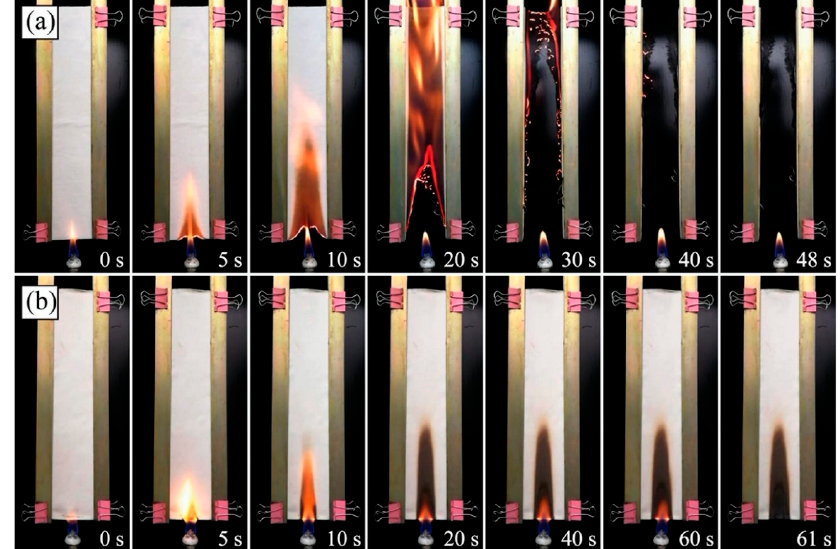
Figure 20. Digital images of uncoated and coated polyester fabrics after Limiting Oxygen Index testing. ( a ) uncoated polyester, ( b ) LbL-treated polyester—1 bi-layer, ( c ) LbL-treated polyester—5 bi-layers, ( d ) LbL-treated polyester—10 bi-layers and ( e ) LbL-treated polyester—20 bi-layers. Reprinted with permission from [50]. Copyright 2019, Elsevier.